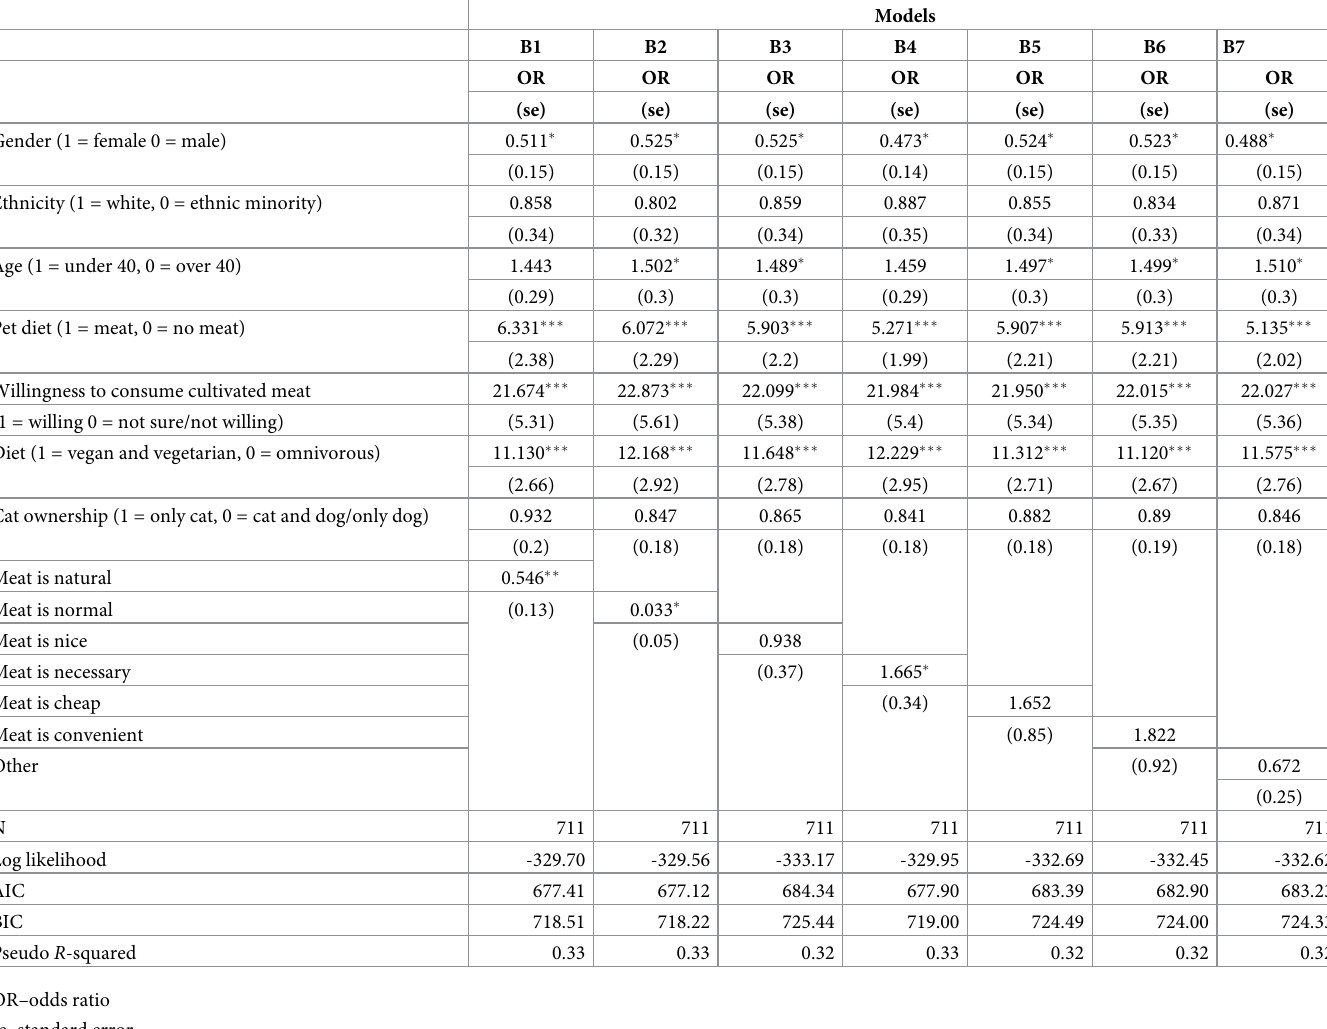
Table 10. Factors predicting the willingness to feed cultivated meat to pets–models including primary concerns about removing animal meat from pets’